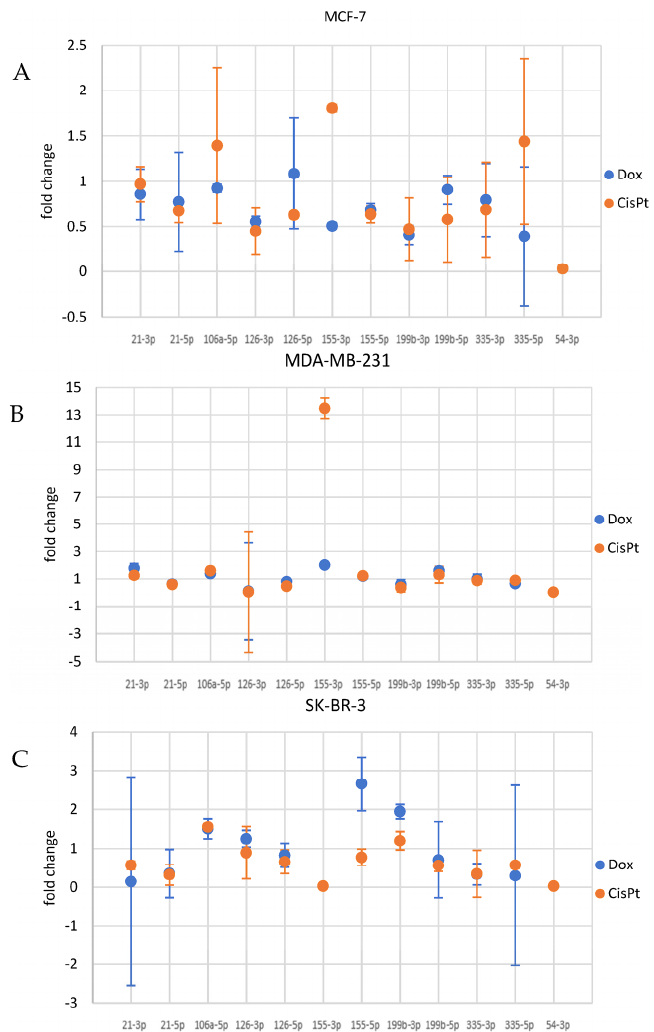
Figure 3. Evaluation of cancer cells response to doxorubicin or cisplatin measured by miRNA levels alterations. All three cell lines (( A ), MCF7; ( B ), MDA − MB − 231; ( C ), SK − BR − 3) were subjected to se- lected miRNAs assessment after treatment with DOX (0.1 μ M) or cis-Pt (10 μ M) for 24 h. Experi- ments were performed in triplicates using RT-qPCR assessment. The values represent fold